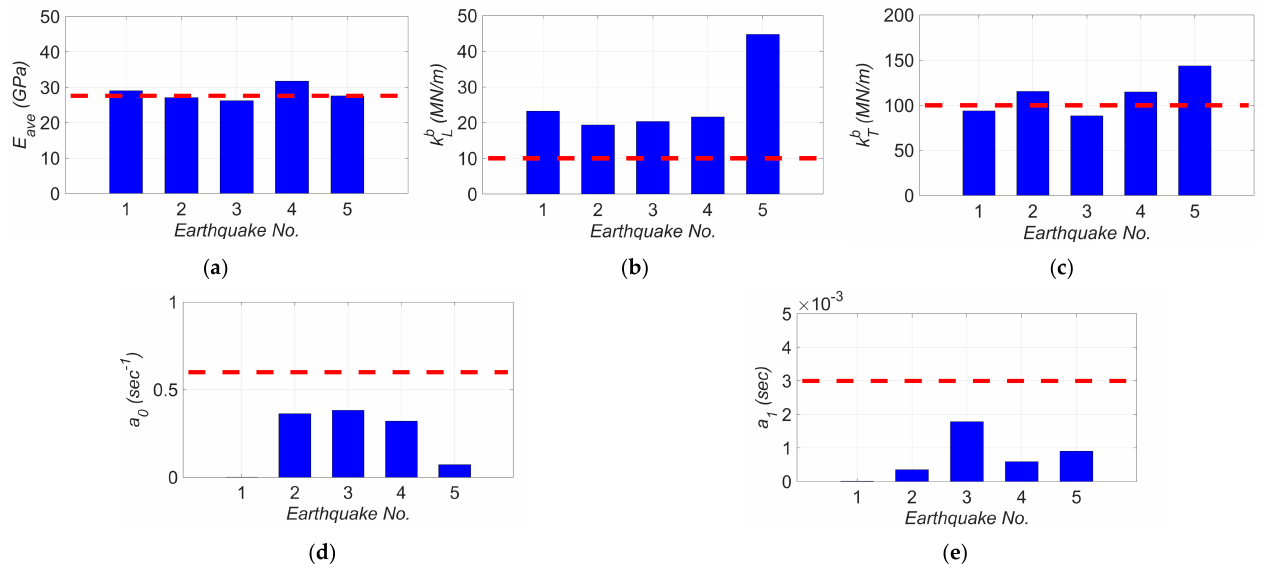
Figure 13. The variation in final estimates of ( a ) (cid:1831) (cid:3028)(cid:3049)(cid:3032) , ( b ) (cid:1863) (cid:3013) (cid:3029) , ( c ) (cid:1863) (cid:3021) (cid:3029) , ( d ) (cid:1853) (cid:2868) , and ( e ) (cid:1853) (cid:2869) for different earthquakes. The red dashed lines show the nominal values.